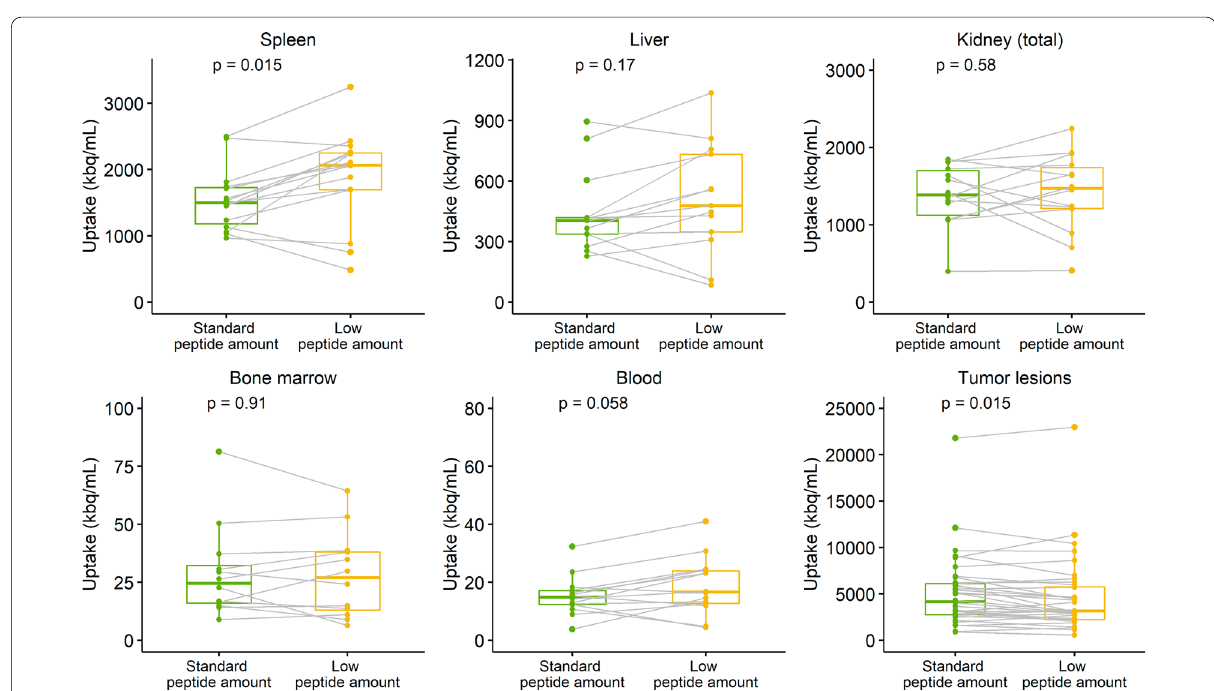
Fig. 4 Results from paired Wilcoxon analyses of organ and tumor uptake differences between standard and low administered peptide amounts activity of [ 177